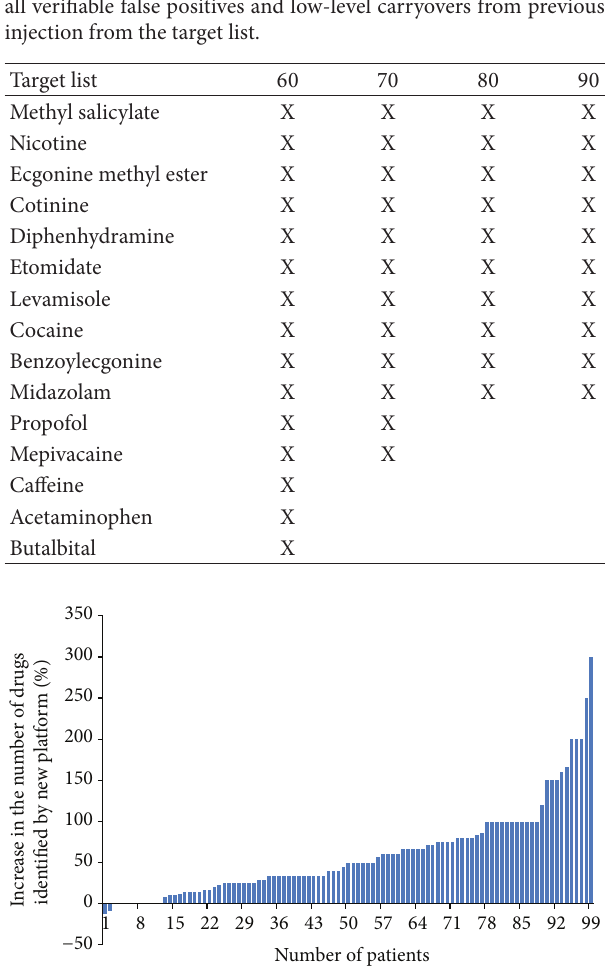
Figure 2: Percentage increase in the number of drugs reported for each patient for the new platform ( > 0) over the number of drugs reported by the reference platform ( < 0). The number of drugs reported per patient for the 99 retrospective patient samples was compared with the number of drugs reported for these patients by clinicaltestingusingthereferenceplatform. The%excess(ordeficit) in the number of drugs reported by the new platform compared to the reference platform is plotted for each patient. For 2 patients, the reference platform reported one drug each (Clonidine and Clozapine) in excess of the number of drugs reported by the new platform for those patients. For 10 patients, both platforms reported equal number of drugs per patient while for all other patients ( 𝑁 = 87 ) the new platform reported more drugs per